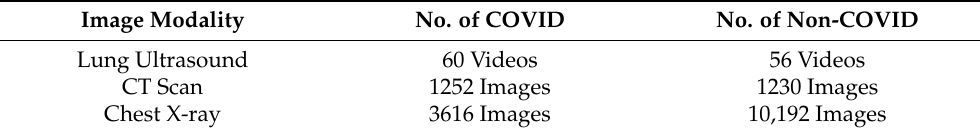
Table 1. Distribution of images in the dataset.